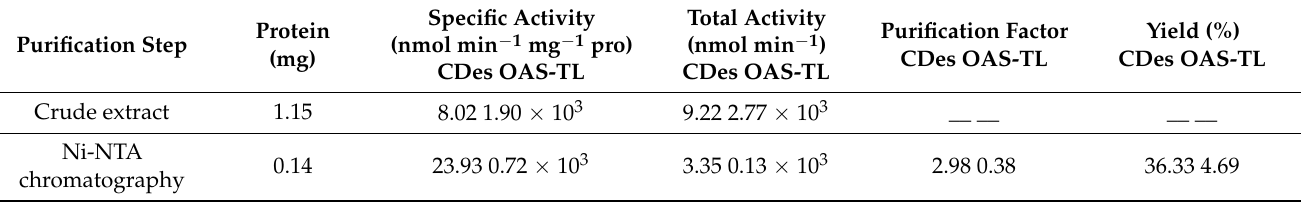
Figure 2. Biochemical characterization of purified recombinant His -tagged OsLCD1 expressed in E. coli . ( A ) Expression and purification of OsLCD1 recombinant protein. OsLCD1 expression was induced with 0.2 mM IPTG for 12 h and then purified by Ni-affinity chromatography. M: Molecular marker; Lane1: Total protein without IPTG induction of BL21 ( DE3 )// pET28α -OsLCD1 ; Lane2 total protein after IPTG induction of BL21 ( DE3 )/ pET28α -OsLCD1 ; Lane3: Expressed protein purified by Ni-affinity chromatography. ( B ) Western blot of purified OsLCD1 recombinant protein. M: Molecular marker; Lane1: immunoblot of purified protein developed with the polyclonal antiserum against the putative OsLCD1 eluted by NTA-50 buffer; Lane2: immunoblot of purified protein developed with the polyclonal antiserum against the putative OsLCD1 eluted by NTA-50 buffer NTA-100. ( C , D ) Temperature and pH dependence of the OsLCD1 reaction. Data shown are means ± SD from three independent measurements. Table 1. The purification and catalytic activity of OsLCD1 expressed in E. coli . The recombinant His -tagged OsLCD1 protein was purified using the Ni-NTA Purification System. CDes and OAS-TL activities were measured as described.